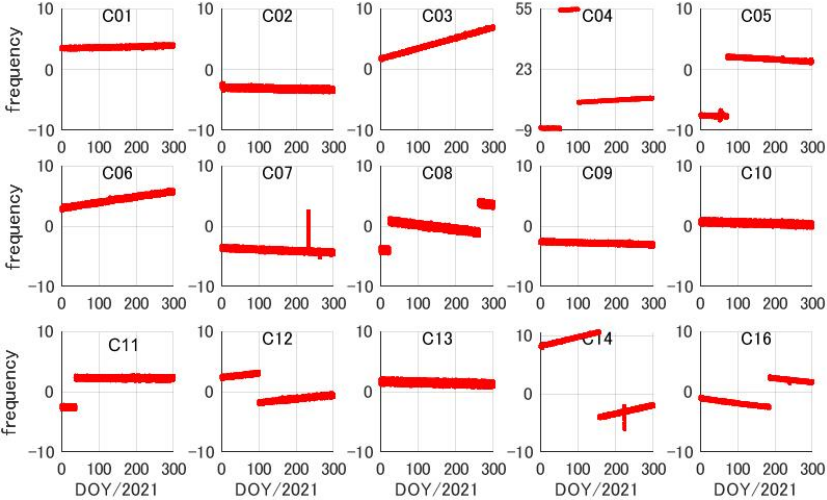
Figure 3. Frequency series of the BDS-2 onboard clocks from DOY 1 to 300, 2021 (units: 10 − 11 s/s).